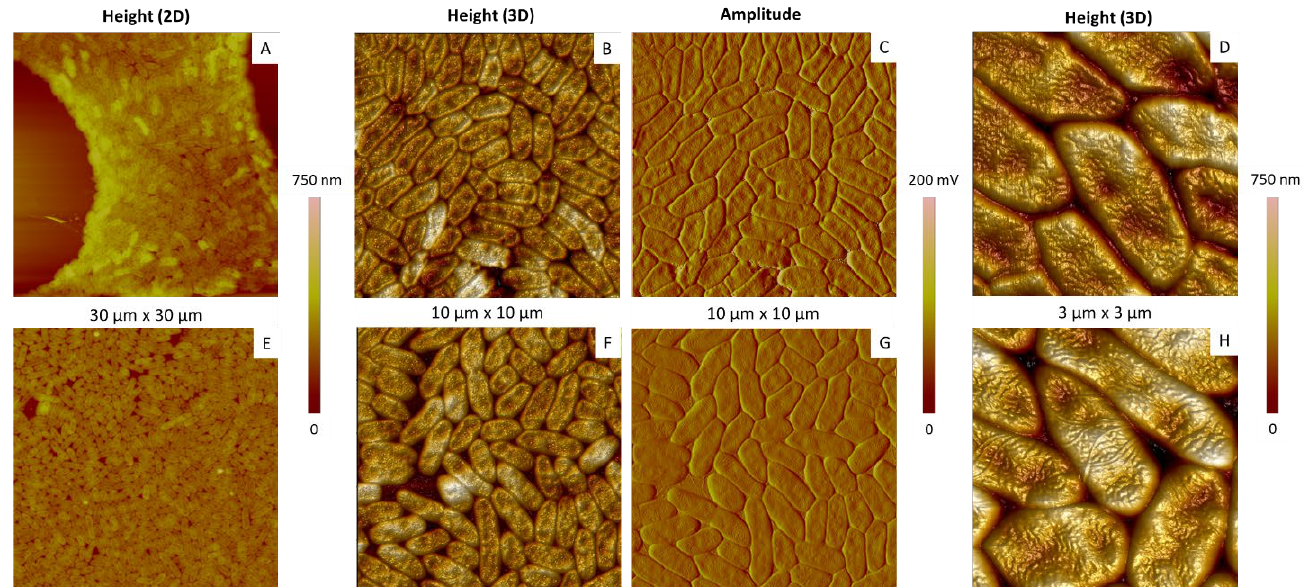
Figure 2. AFM height or amplitude images of P. fluorescens deposits obtained by simple deposition ( A – D ) or spin-coating ( E – H ).